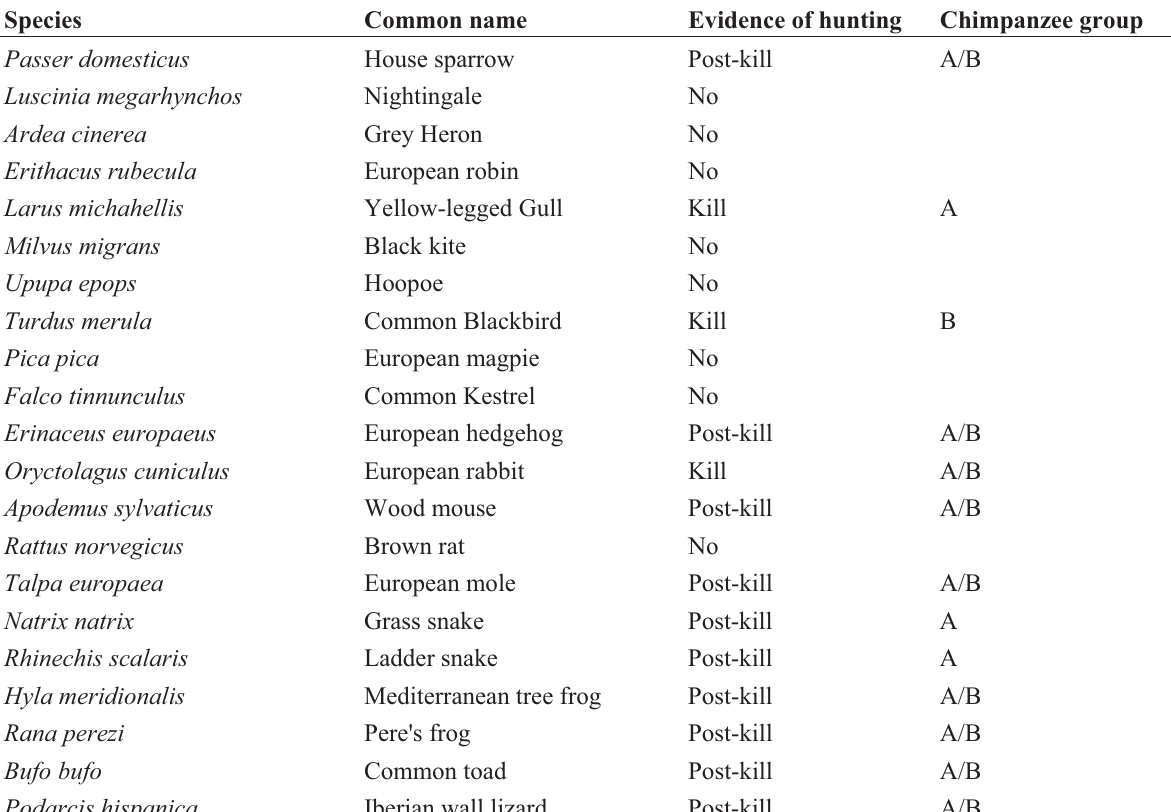
Table 3. Native wildlife at FM with killing and post-killing